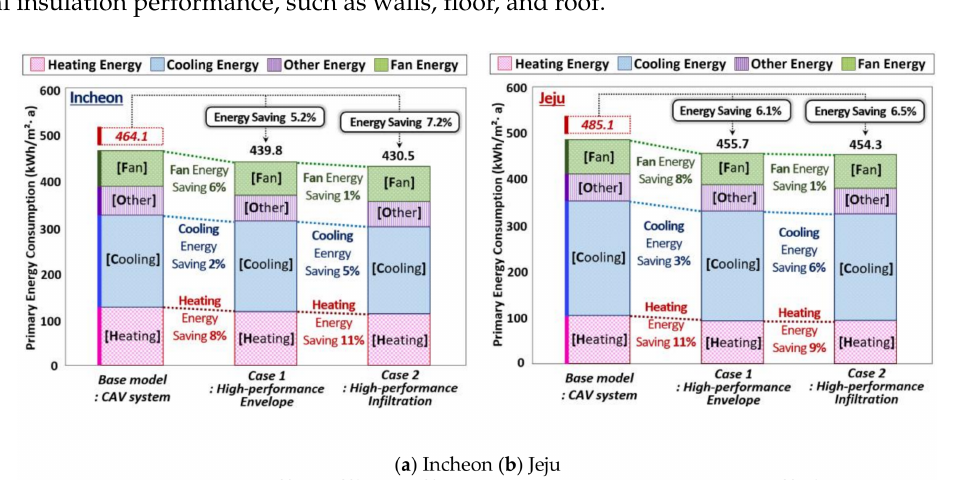
Figure 11. Primary energy consumptions and energy saving potential (%) of Case 1 and Case